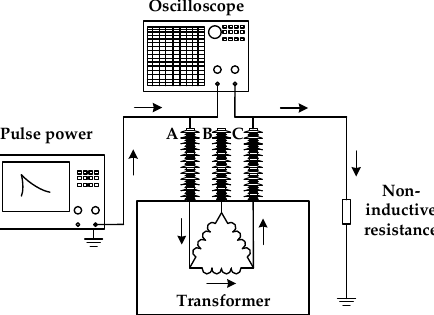
Figure 16. Experimental wiring diagram.